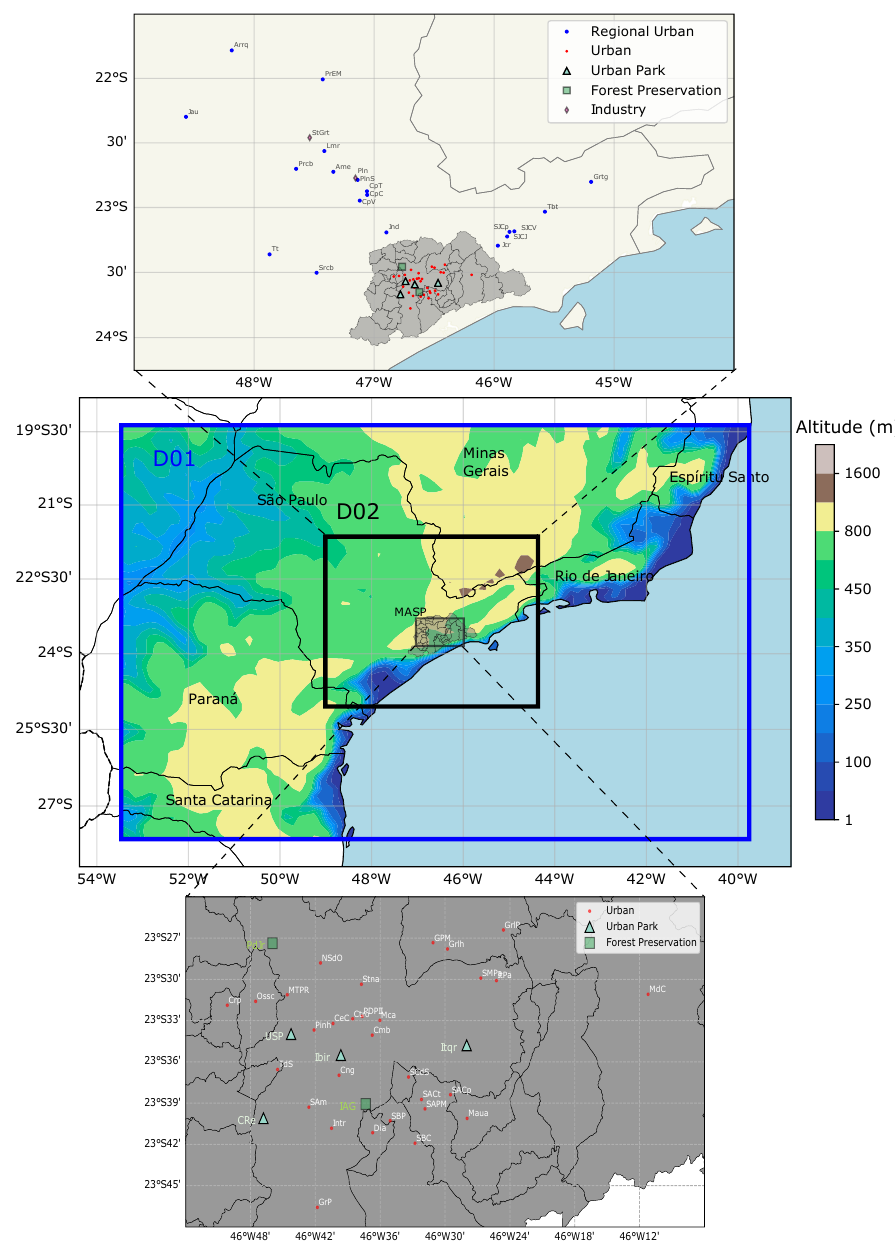
Figure 1. Modeling domain area and stations network in the MASP as points to compare with simulations (Reprinted/adapted with permission from Ref. [37]. 2021, Universidade de São